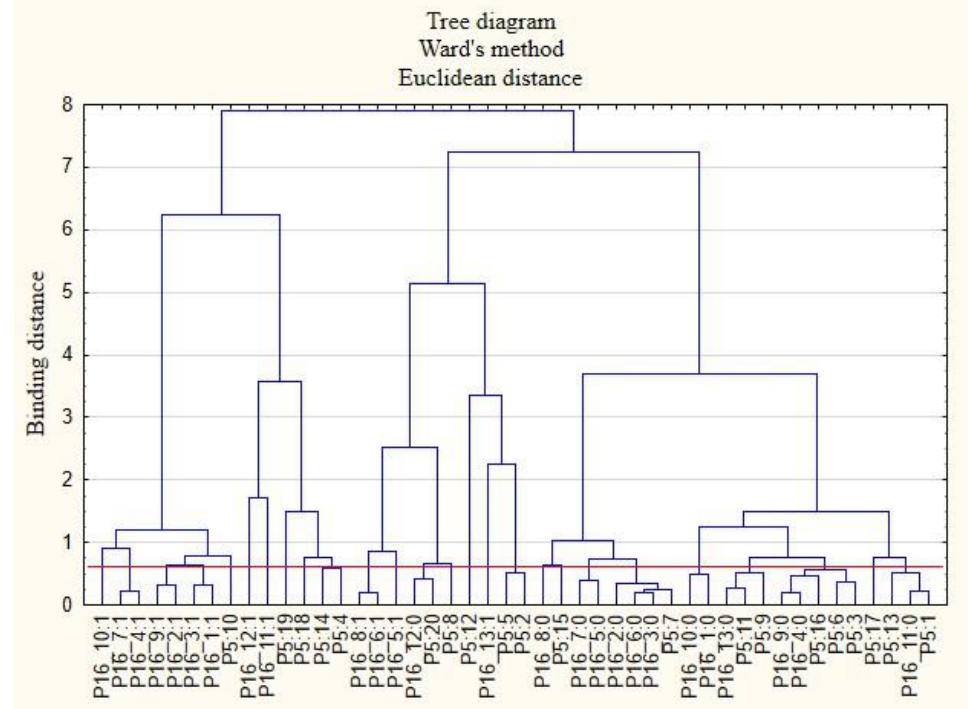
Figure 10. Diagram of hierarchical classification of variable categories: support that respondents want to receive after the end of the COVID-19 pandemic from the employer in the area of healthcare and the effective use of the benefits offered (P16) as well as the industries in which the respondents work (P5).